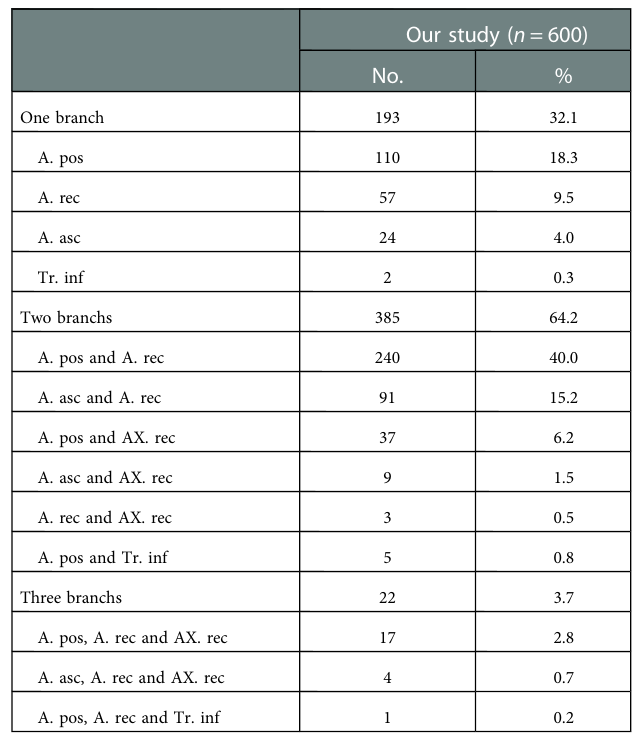
TABLE 2 The composition of A2.